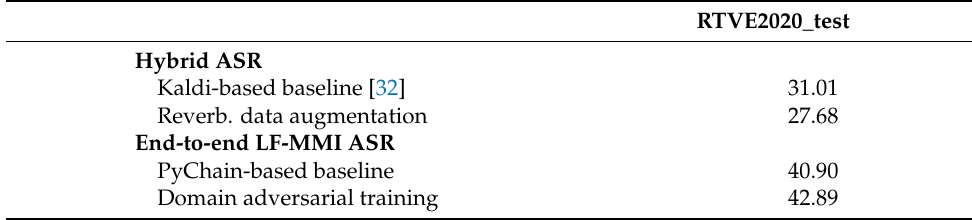
Table 3. WER (%) on the RTVE2020 test partition for all the systems. Results were obtained after the